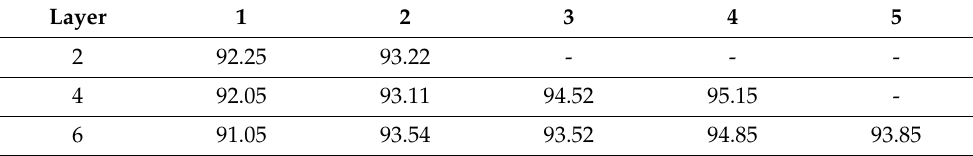
Table 3. Quantitative evaluation of different transformer decoder module number on TuSimple validation set (%). The horizontal coordinate is transformer decoder module number, the vertical co- ordinate is transformer encoder number, and the evaluation metric is mAP (mean Average Precision). Layer 1 2 3 4 92.25